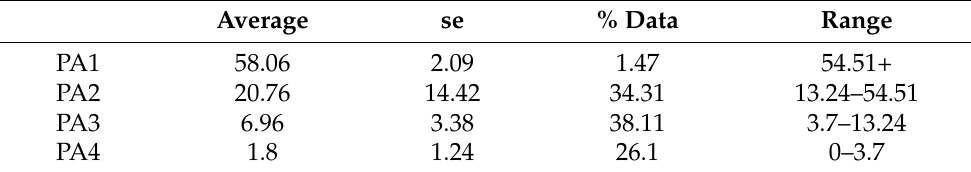
Table 1. Parameters of the four distributions that constitute the distribution mixture model: average value, standard error, proportion of data in the distribution, and the length thresholds that were used to classify annual shoots into physiological ages